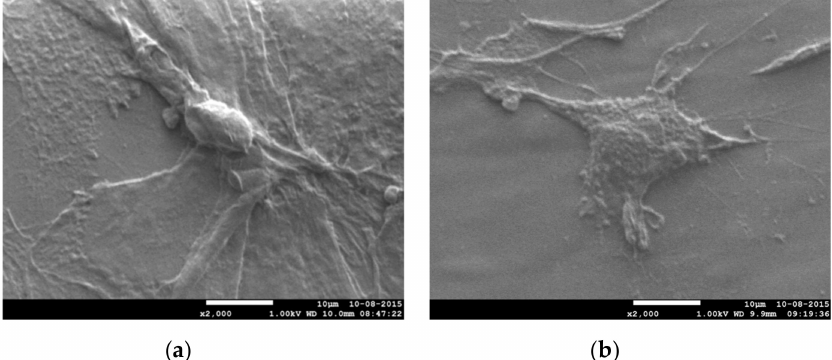
Figure 12. The images of surfaces: ( a ) surface of gas-oxidized titanium, and ( b ) surface of gas-oxidized titanium with a cell detected with CFSE reagent. Magnification 500 × .